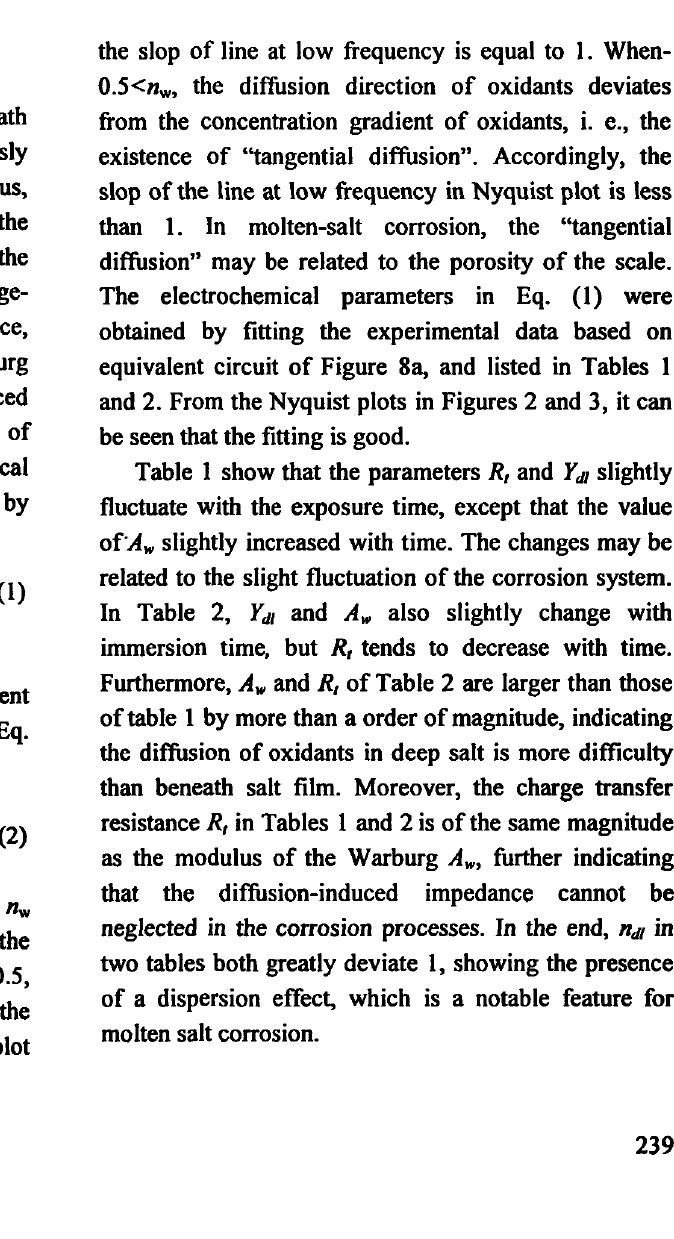
-KCl mixture at 673 K in 2